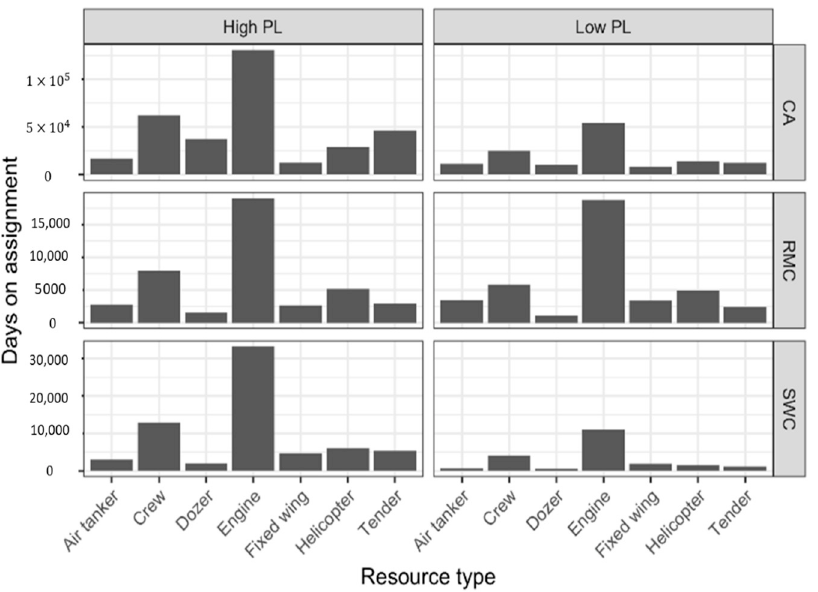
Figure 2. The total number of days each resource type were assigned to fire suppression during the three ‐ year analysis period (2016 to 2018) at high or low preparedness levels (PL).